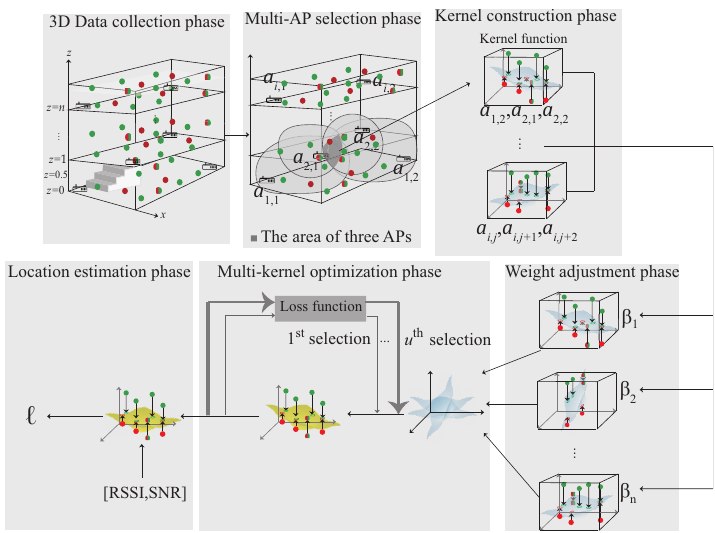
Figure 5. The 3D iterative multi-kernel optimization.